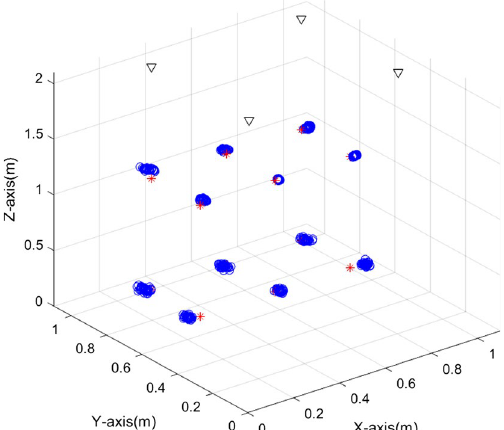
Fig. 6 Estimated (denoted by blue circles) versus real position (denoted by red stars) for multiple receiver positions. Transmitter positions are denoted by